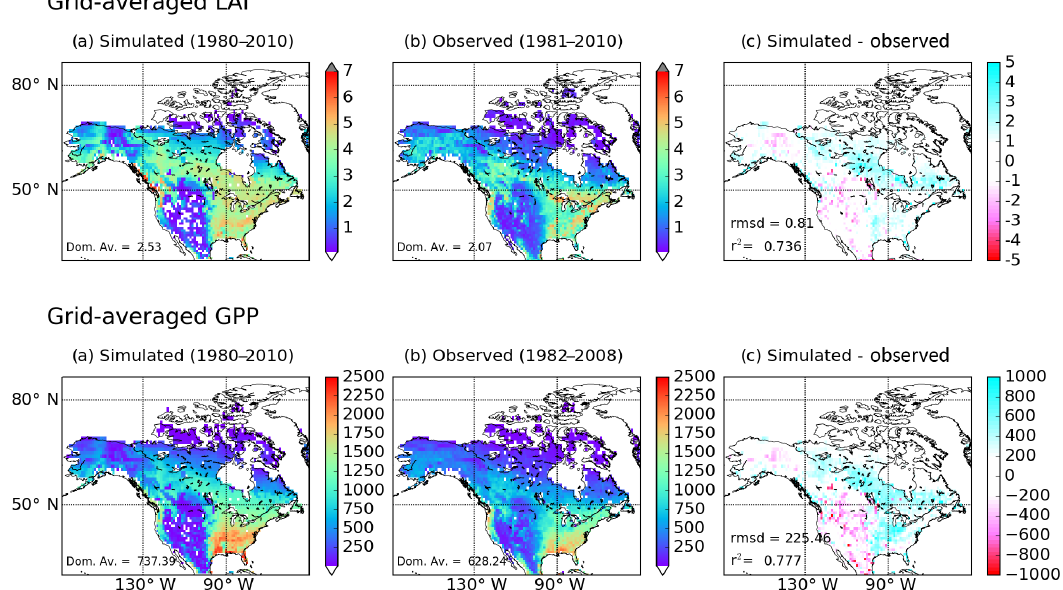
Figure 9. Spatial distribution of grid-averaged maximum LAI (m 2 m − 2 ) (upper row) and grid-averaged GPP (gCm − 2 yr − 1 ) (bottom row) across North America. Simulated values are shown in (a) , observation-based values in (b) and differences between them are shown in (c) , which also shows the root mean square difference (rmsd) and spatial correlation ( R 2 ) between simulated and observation-based values.